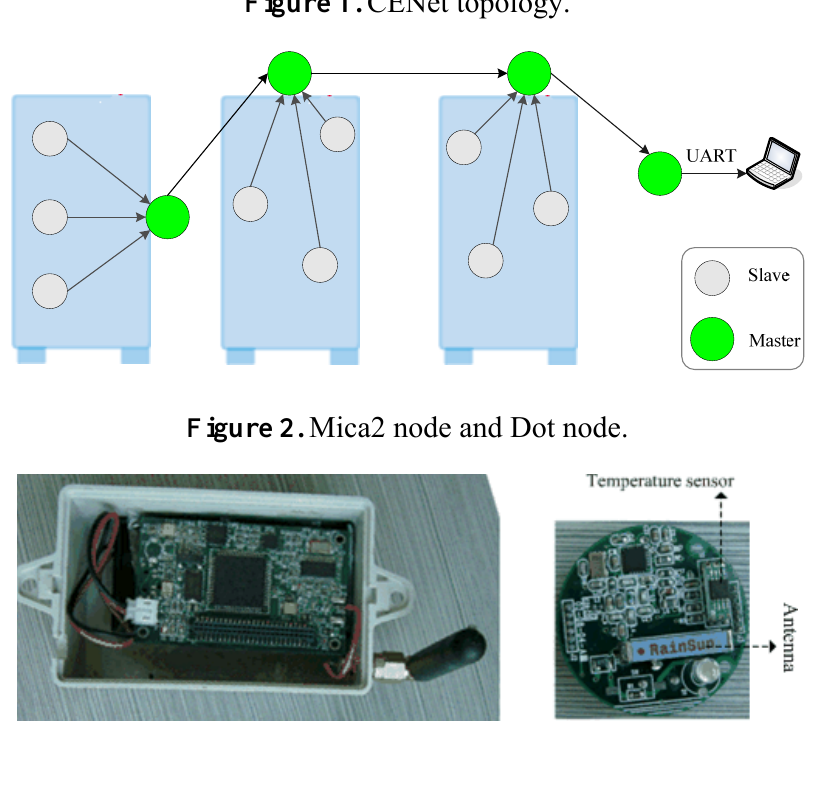
Figure 1. CENet topology.